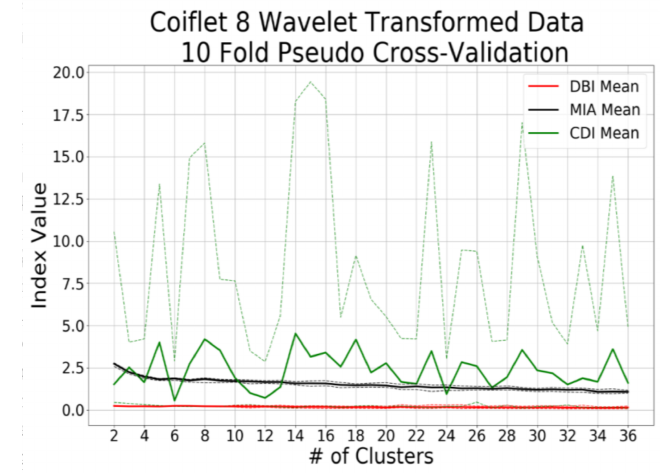
Figure 9. Cluster validation index development from 2 to 36 clusters using Coiflet 8